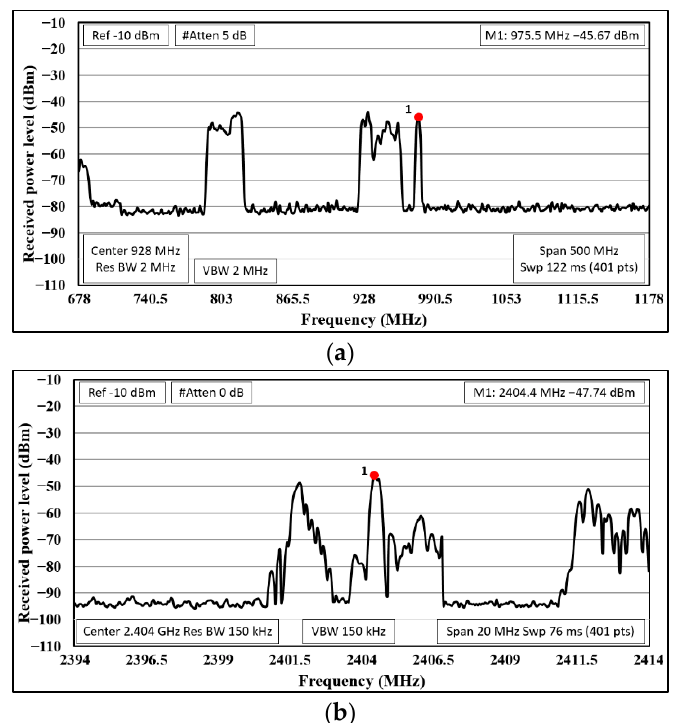
Figure 4. Existing signals in the frequency bands of interest within Hole number 1: ( a ) around 900 MHz; ( b ) around 2.4 GHz.